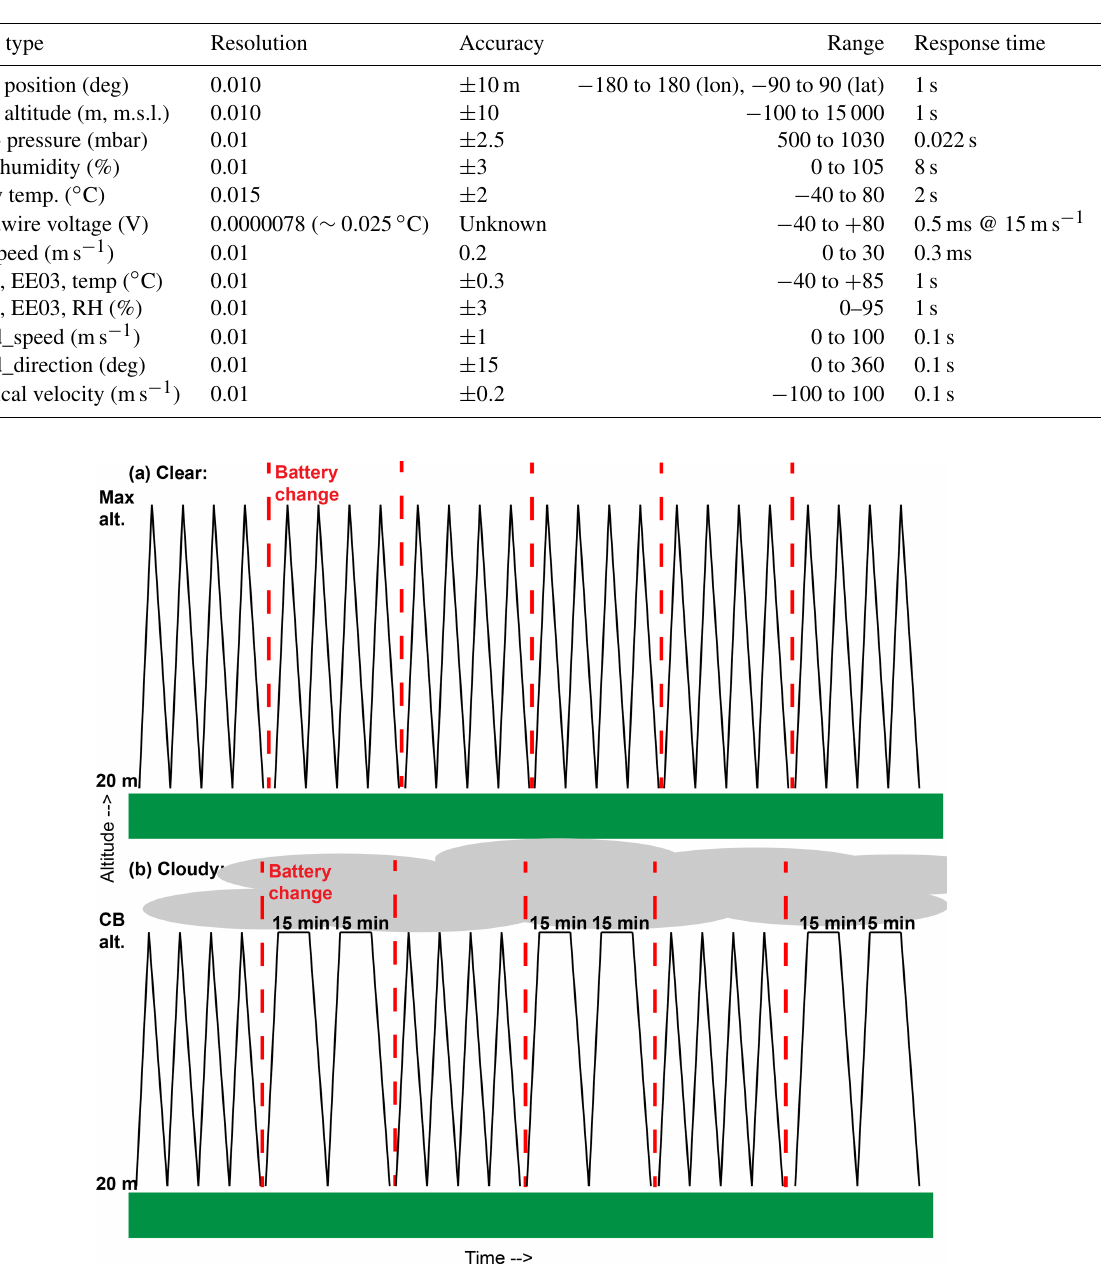
Table 2. Known performance characteristics for DataHawk2 instruments. Note that accuracy estimates of wind values are estimated based on recent intercomparison with surface-based instrumentation and apply to a higher-order derived product.